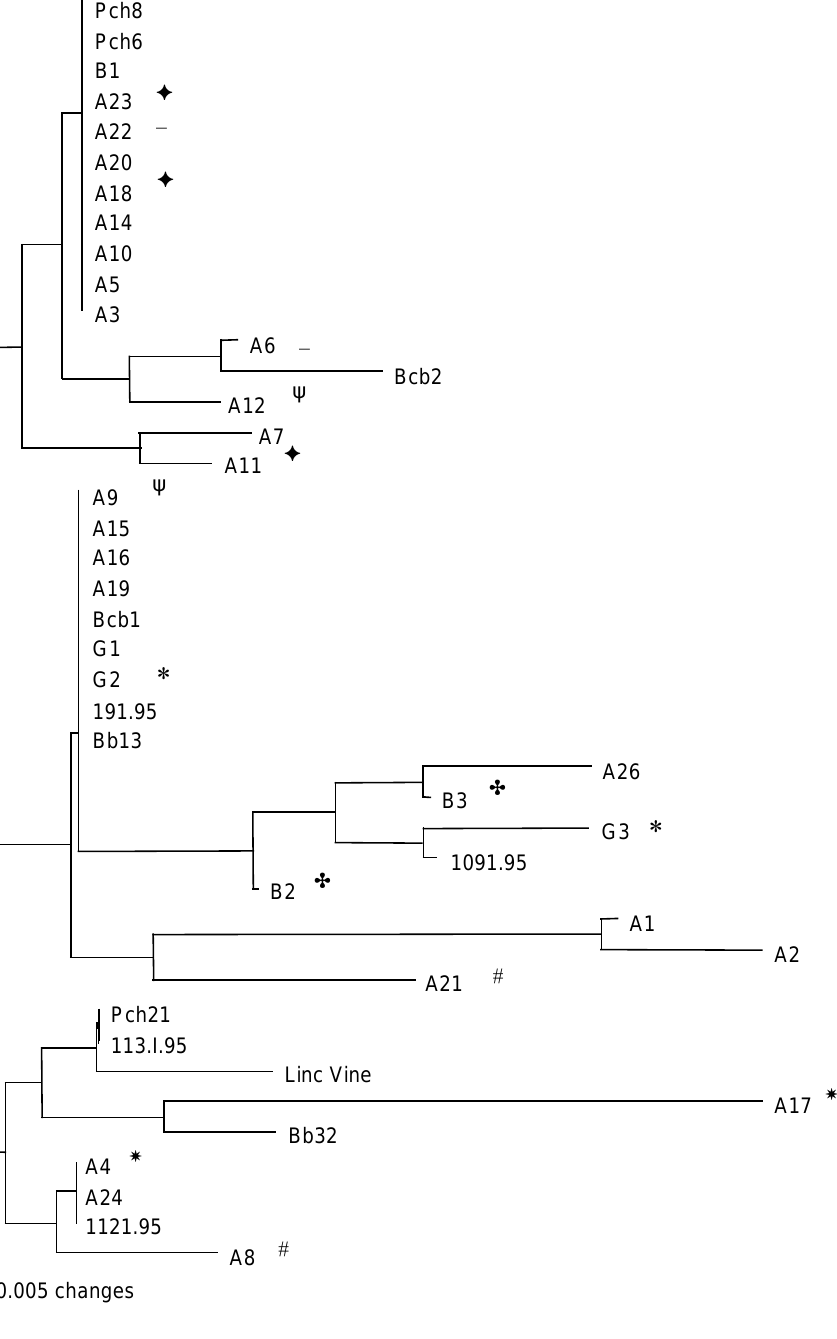
Fig. 5. Neighbour joining dendrogram generated by cumulative binomial tables using AFLP primers. Matching symbols to the right of isolates indicate that the isolates were from the same